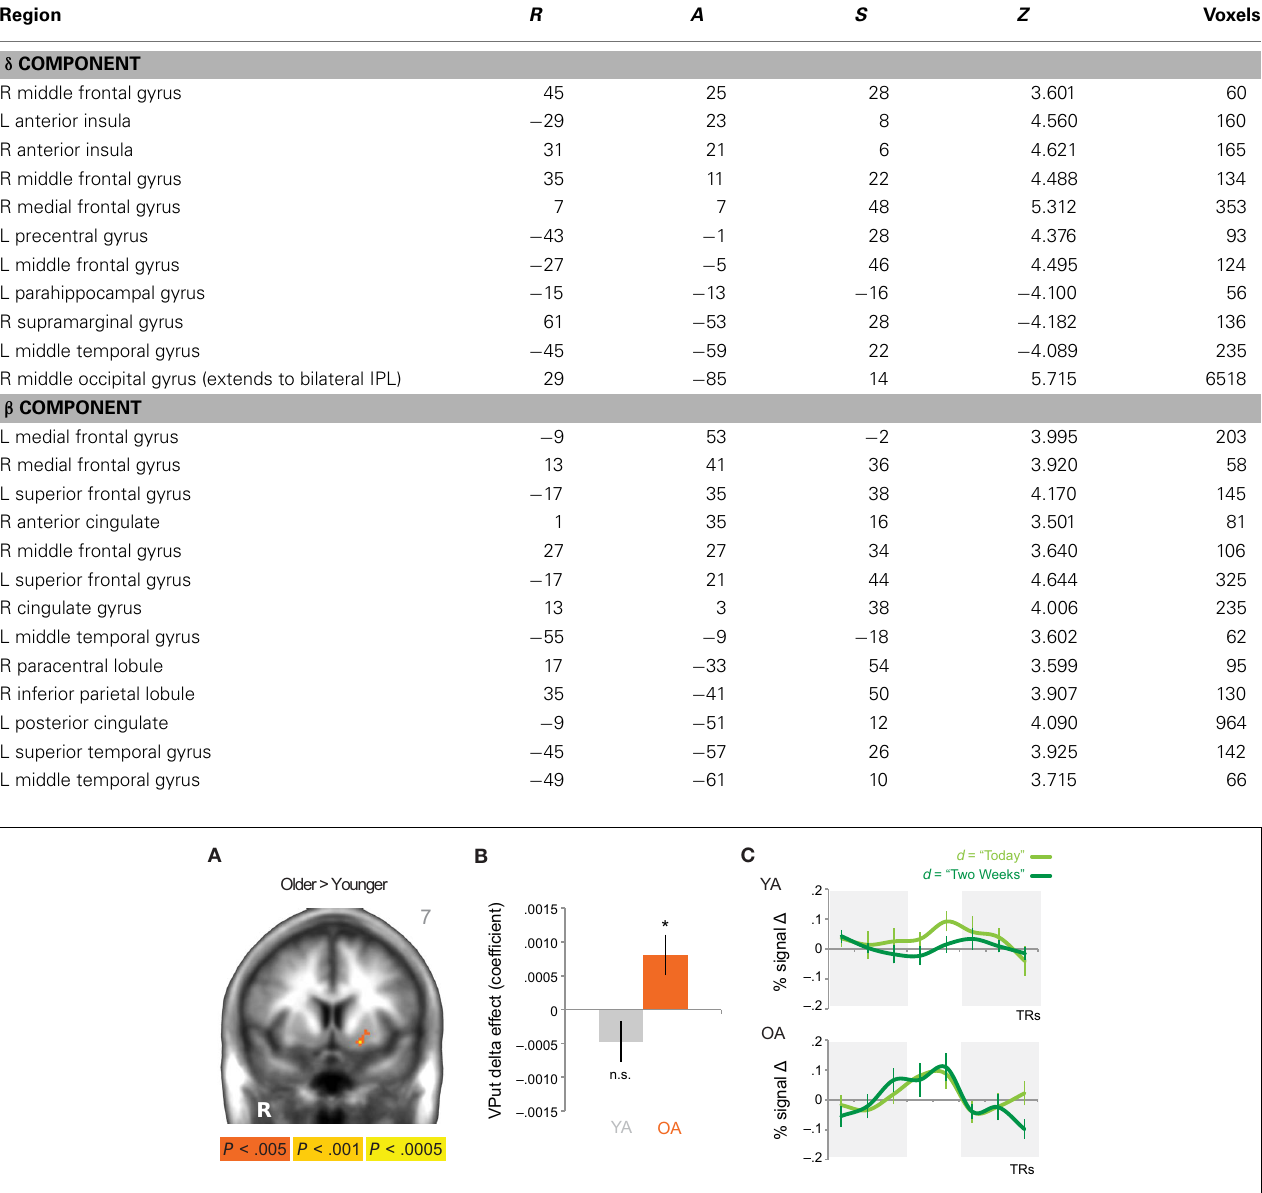
FIGURE 3 | (A) The δ component (low discount rate) was more strongly associated with neural activity in theVPut (ventral putamen) in older compared to younger adults. R = right. A = 7. Anatomical underlay is an average of all subjects’ spatially normalized structural scans. (B) Significant δ -related neural activity in theVPut in older but not younger adults. * p <